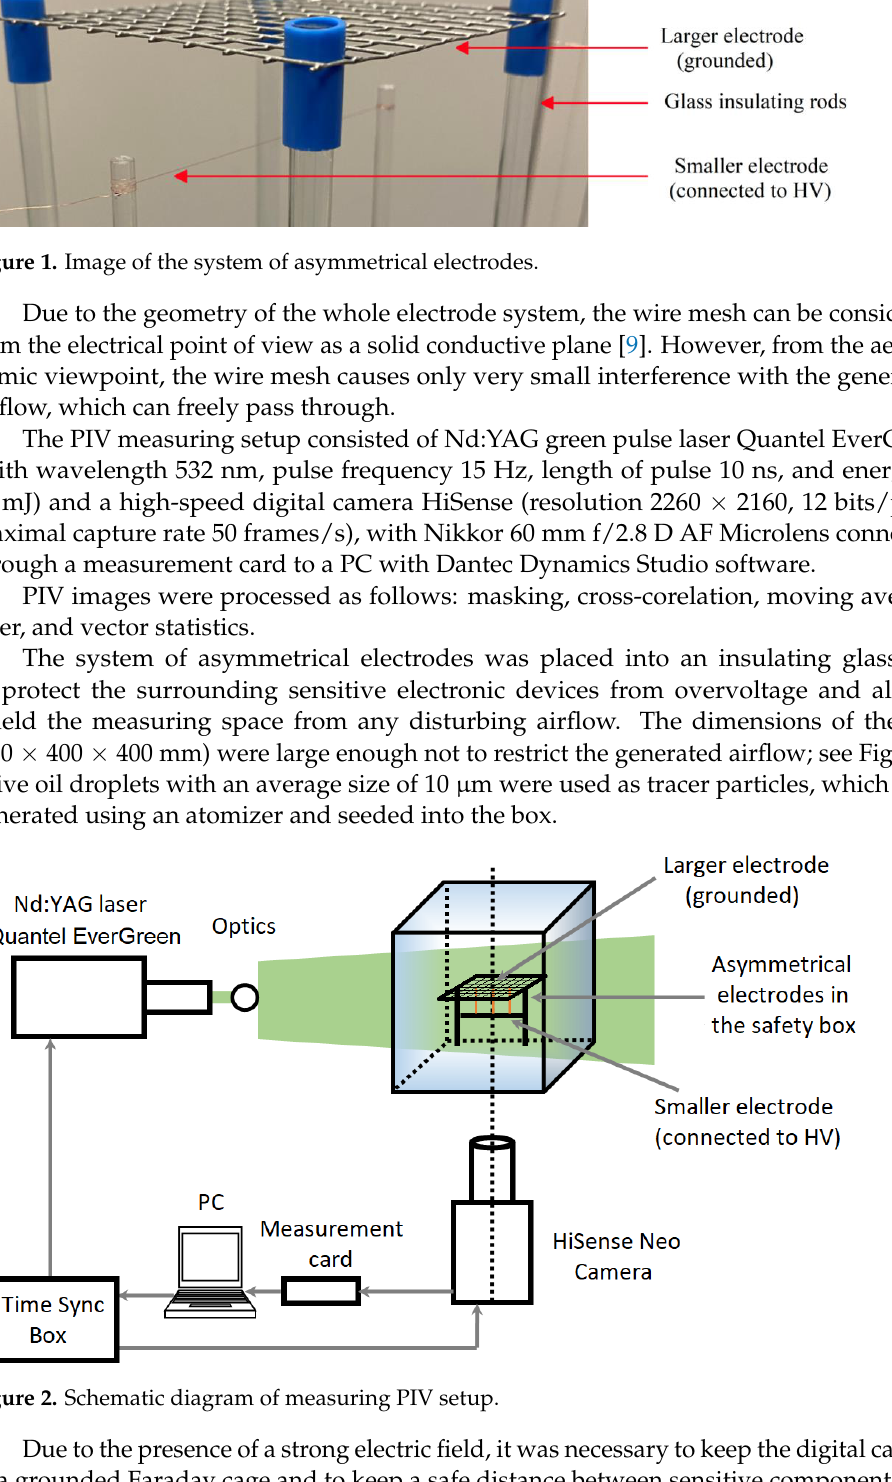
Figure 2. Schematic diagram of measuring PIV setup.